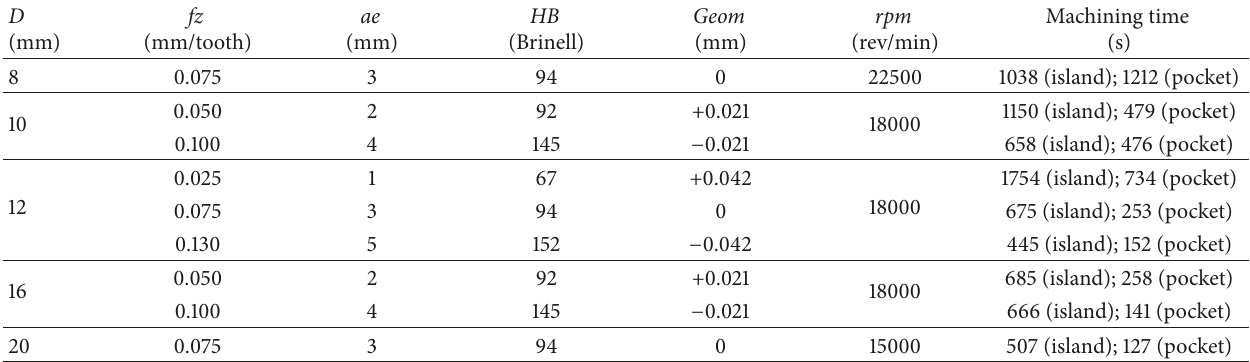
Figure 5: Different geometry forms used during the experimentation. Table 1: Factors and factor levels used in the DoE in experiment.